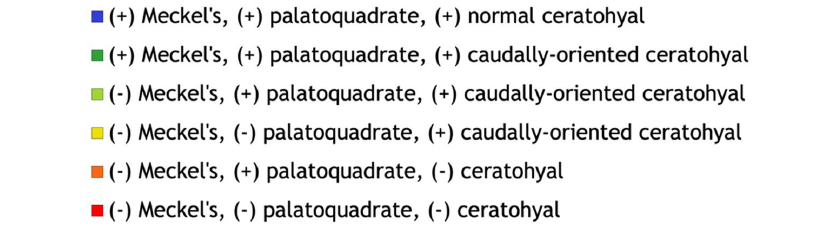
Figure 3. Effects of the initial timing of APAP treatment on the development of select first and second pharyngeal arch-derived cartilages. A quantification of the defects shown in Figure 2. The number of alcian blue-stained larvae analyzed for each group are in parentheses at the top of each column.